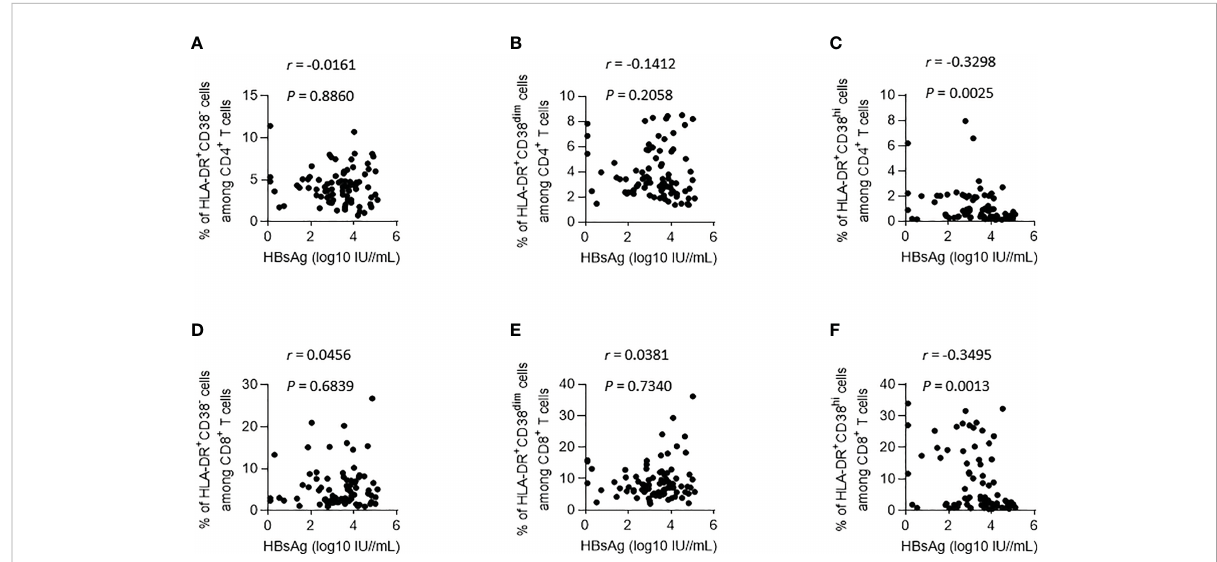
FIGURE 2 Correlations between HBsAg and HLA-DR + subgroups (according to the expression of CD38) on CD4 + and CD8 + T lymphocytes during IFN Treatment. (A – C) Correlations between HBsAg and HLA-DR + CD38 - (A) , HLA-DR + CD38 dim (B) and HLA-DR + CD38 hi (C) on CD4 + T lymphocytes. (D – F) Correlations between HBsAg and HLA-DR + CD38 - (D) , HLA-DR + CD38 dim (E) and HLA-DR + CD38 hi (F) on CD8 + T